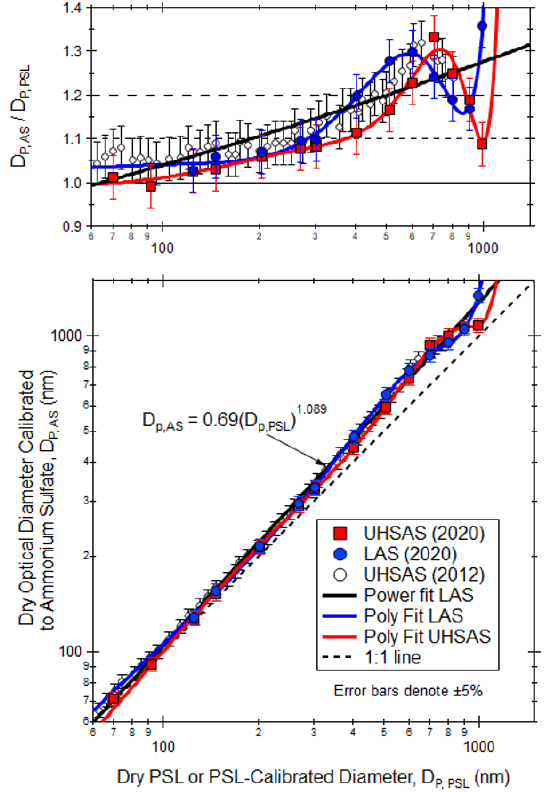
Figure 7. Comparison of LAS and UHSAS optical diameter (cali- brated using ammonium sulfate) to NIST-traceable polystyrene la- tex sphere (PSL) particle sizes during the 2020 laboratory experi- ments (red and blue points). The data are fit to a simple power-law function as well as a sixth-order polynomial function, both with the intercept forced through the origin. Also shown for comparison as open circles are DMA-classified ammonium sulfate aerosol sizes plotted versus the UHSAS sizes during the 2012 DC3 mission (cal- ibrated using PSLs). Raw data for this figure are available in the Supplement.